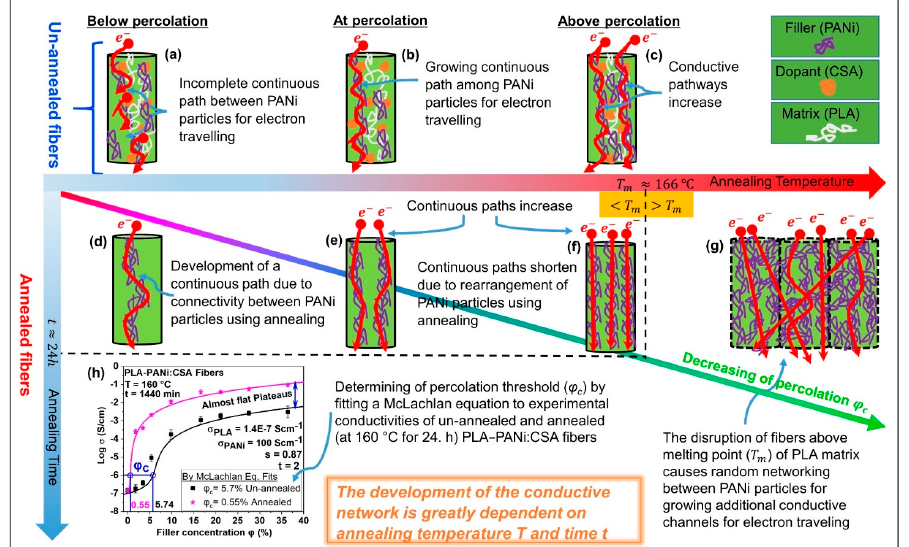
Figure 2. Schematic representation of percolation phenomenon within electrospun conductive nanofibers with and without annealing. ( a ) shows the incomplete continuous path between PANi (filler) particles (below the critical concentration/percolation threshold). ( b ) shows the completion of a continuous path between PANi particles for percolation phenomenon (at percolation threshold). ( c )